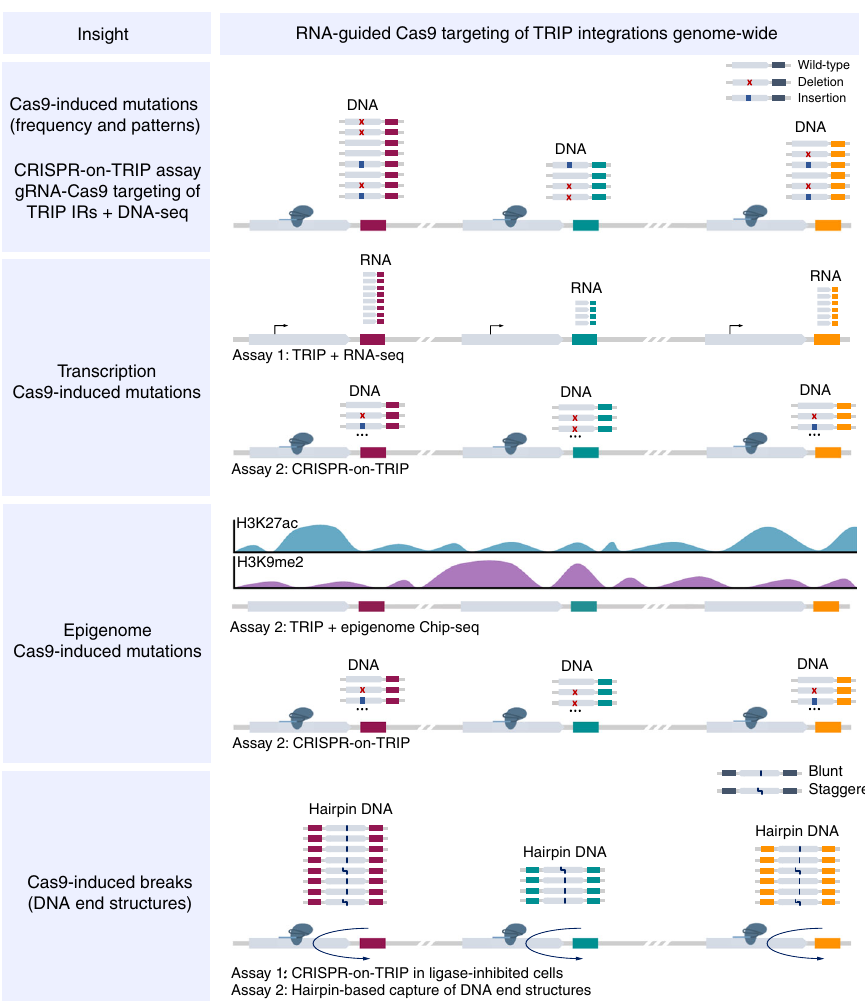
Fig. 7 Potential applications of CRISPR-on-TRIP. RNA-guided Cas9 targeting of regions within integrated TRIP reporters (CRISPR-on-TRIP) can be combined with other assays to investigate effects of various processes on Cas9-induced mutation frequency and